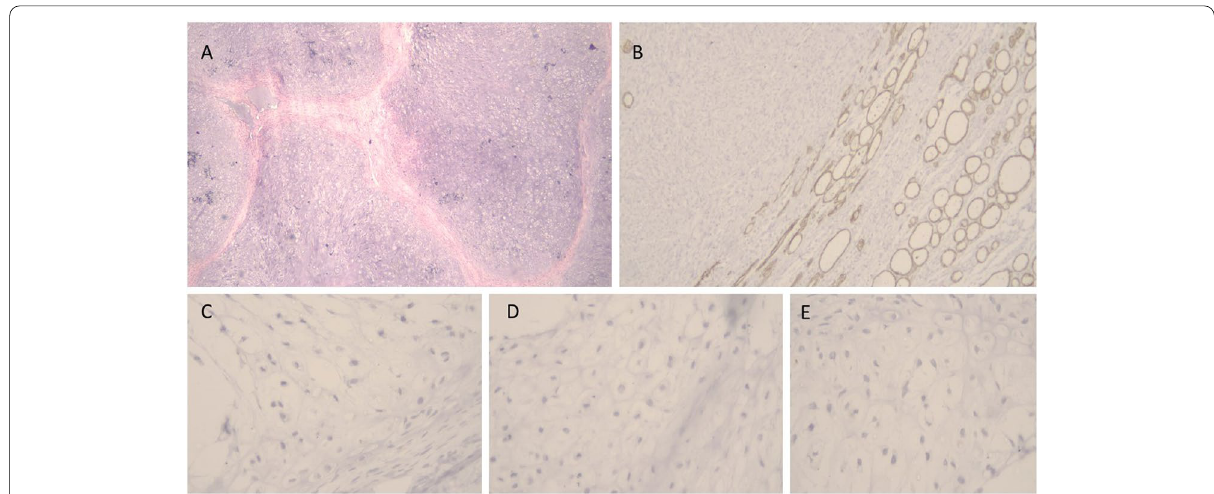
Fig. 3 A Tumor formed of lobules of malignant chondrocytes embedded in a chondroid matrix and separated by fibrous septa, H&E 100 cells were negative for thyroglobulin in contrast to entrapped thyroid follicles which were positive for thyroglobulin 200 negative for TTF-1, 400 . D Tumor cells were negative for PAX-8, 400 ×